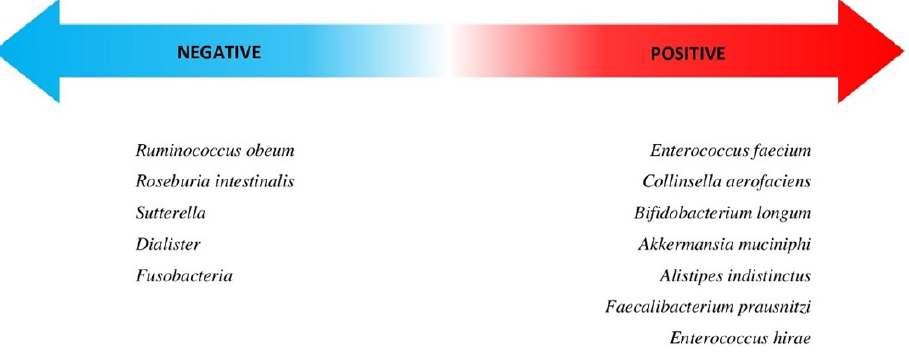
Figure 1. The influence of selected gut microbiome on anti-PD-1/anti-PD-L1 therapy [25,27,36,65,67,